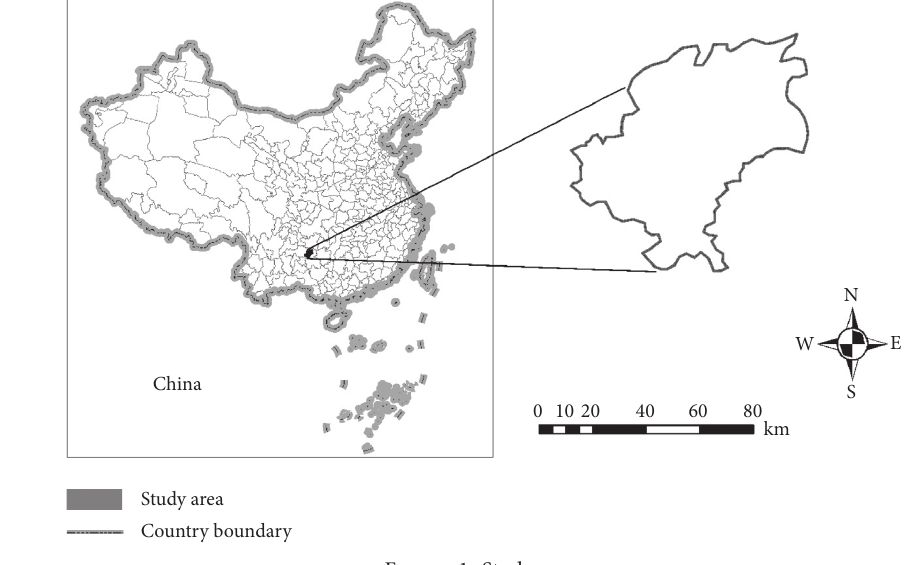
Figure 1: Study area. Table 1: Classification of urban POI data in